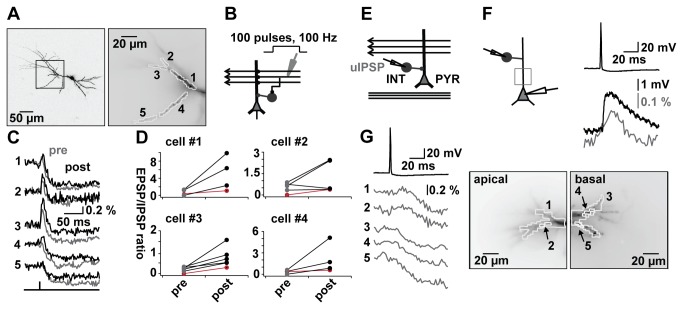
Plasticity of EPSP-IPSP patterns.A. Left: two-photon reconstruction of pyramidal cell. Rectangle represents recording site. Right: ROI in apical dendrite (1-5). Averaged pixels per ROI ~20-50. B. Schematic illustration of plasticity protocol. Application of tetanus in SC (100 pulses, 100 Hz). C. Trace-overlay of evoked potentials before (pre, grey) and after (post, black) the tetanic stimulation for one example cell. Region assignment as in A. Signals are averages of 8 for pre, respectively 4 for post tetanic trials. D. Plots of EPSP-IPSP ratios pre- and post-tetanus for different ROIs in apical dendrites of 4 cells. Red traces indicates the most proximal dendritic compartment. Size of ROIs ~20-50 pixels. E. Schematic configuration illustration for synaptically connected cell pair recording between INT of stratum radiatum and PYR to measure unitary IPSPs (uIPSPs). F. Simultaneous somatic electrical (black bottom trace) and dendritic optical ΔF/F (grey trace) recording of an uIPSP in response to a spike in presynaptic interneuron (top trace). Signals are averages of 3 trials. G. Example of optical recordings of uIPSPs at higher spatial resolution. Left: top trace spike in presynaptic interneuron, optical traces of evoked uIPSP in ROI (average of 3 trials). Region assignment on the right. Right: fluorescence image of apical (region 1, 2) and basal (region 3-5) dendritic ROIs of sample CA1 pyramidal cell. ROI 1 and 3 are spatial averages over the whole dendrite in focus.